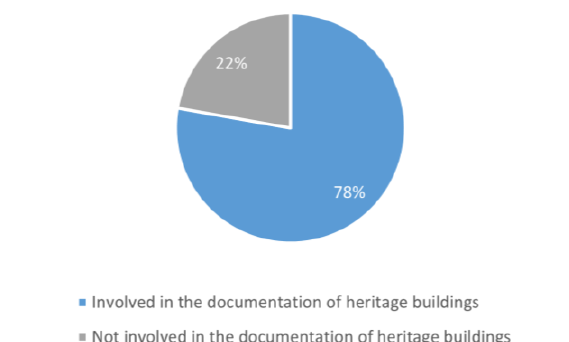
Figure 12: Involvement in the phase of documentation of heritage buildings.